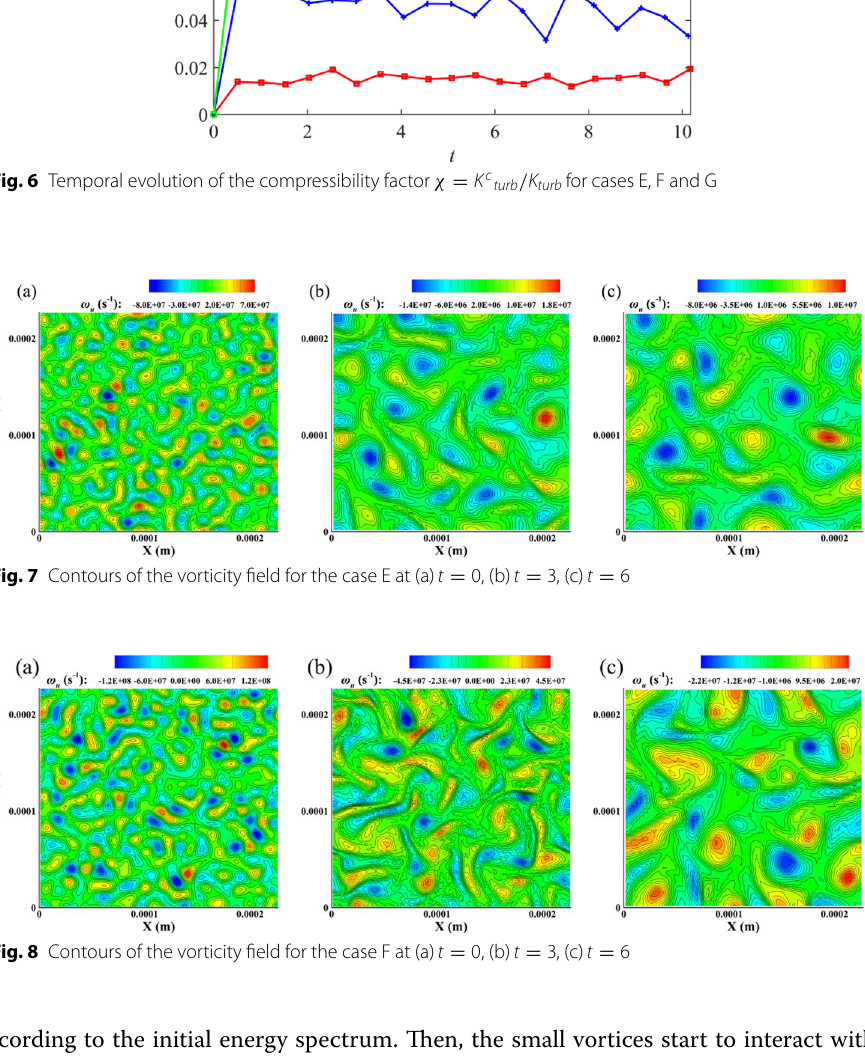
according to the initial energy spectrum. Then, the small vortices start to interact with each other to form the larger vortices, and the vorticity filaments can be observed [57,